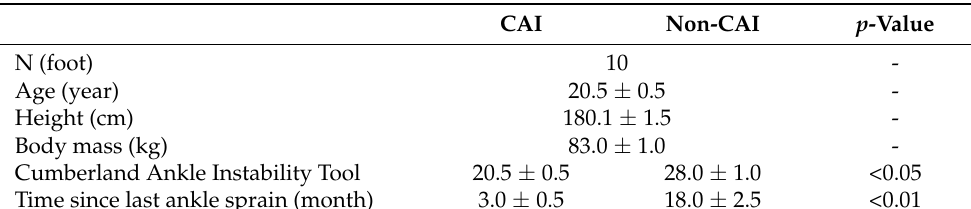
Table 1. Ten athletes who have unilateral chronic ankle instability (CAI).